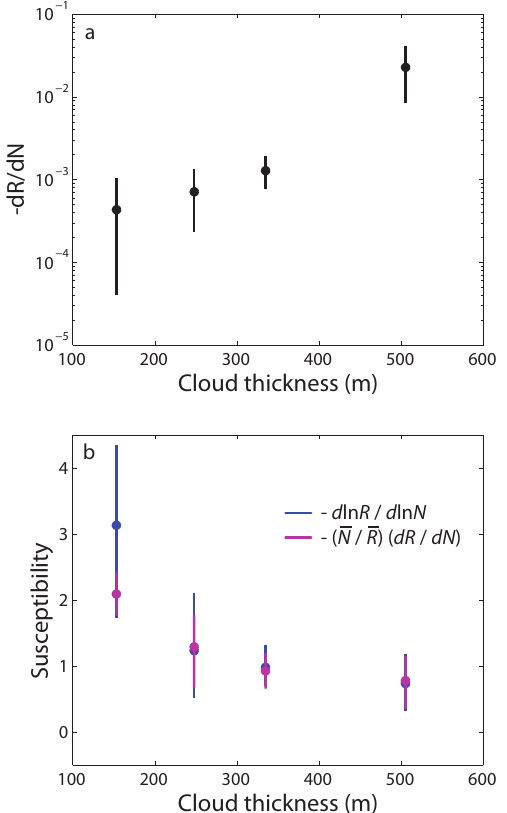
Fig. 4. (a) − dR/dN calculated in the four cloud thickness bins, as described in the Sect. 3.3. (b) The susceptibility calculated using the original formulation of susceptibility (blue) and the susceptibility calculated using the formulation in Eq. (6)